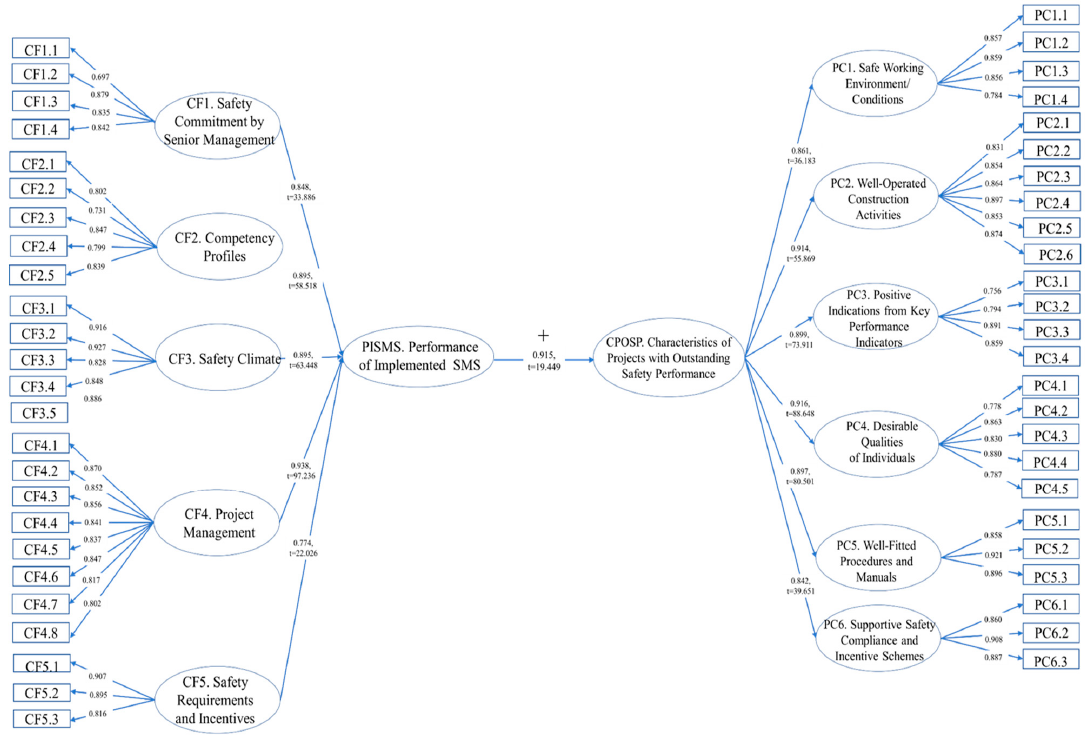
Figure 3. Path Estimates of the Structural Model.